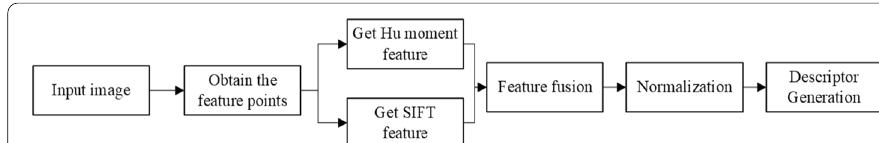
Fig. 7 The block diagram of the parallel feature fusion process